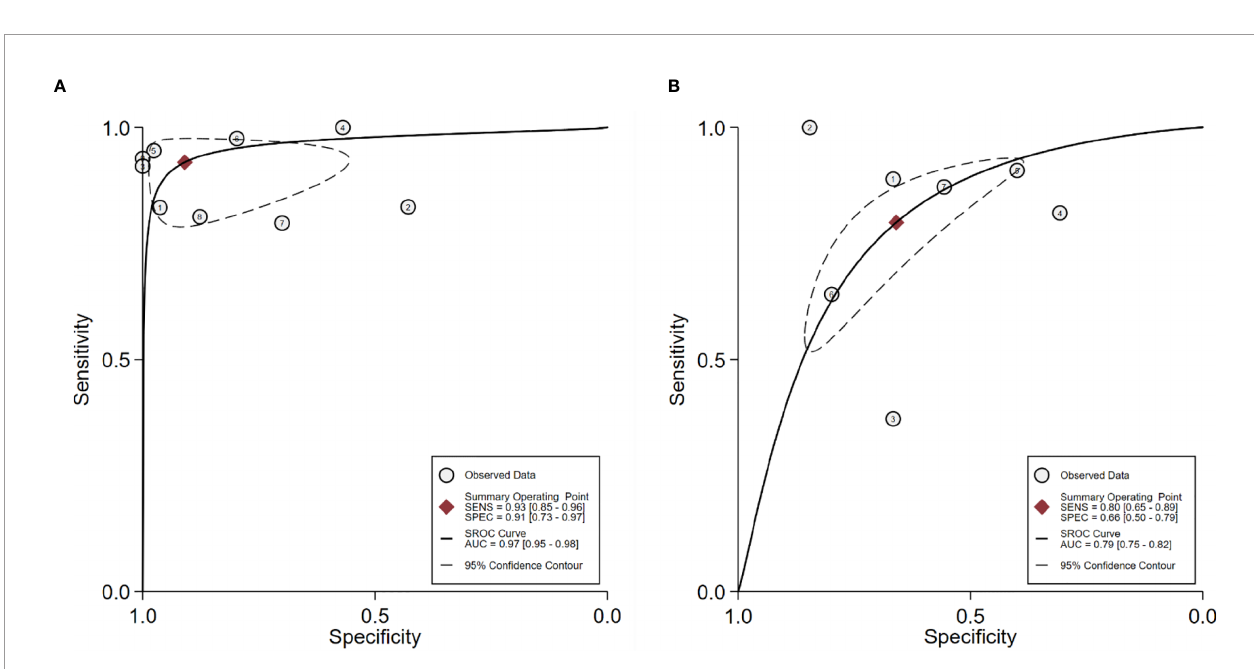
FIGURE 5 | (A) SROC curve for the diagnostic accuracy of 18 F-choline PET/CT in prostate cancer patients with biochemical recurrence. (B) SROC curve for the diagnostic accuracy of 18 F- fl uciclovine PET/CT in prostate cancer patients with biochemical recurrence. SROC, summary receiver operating characteristic.